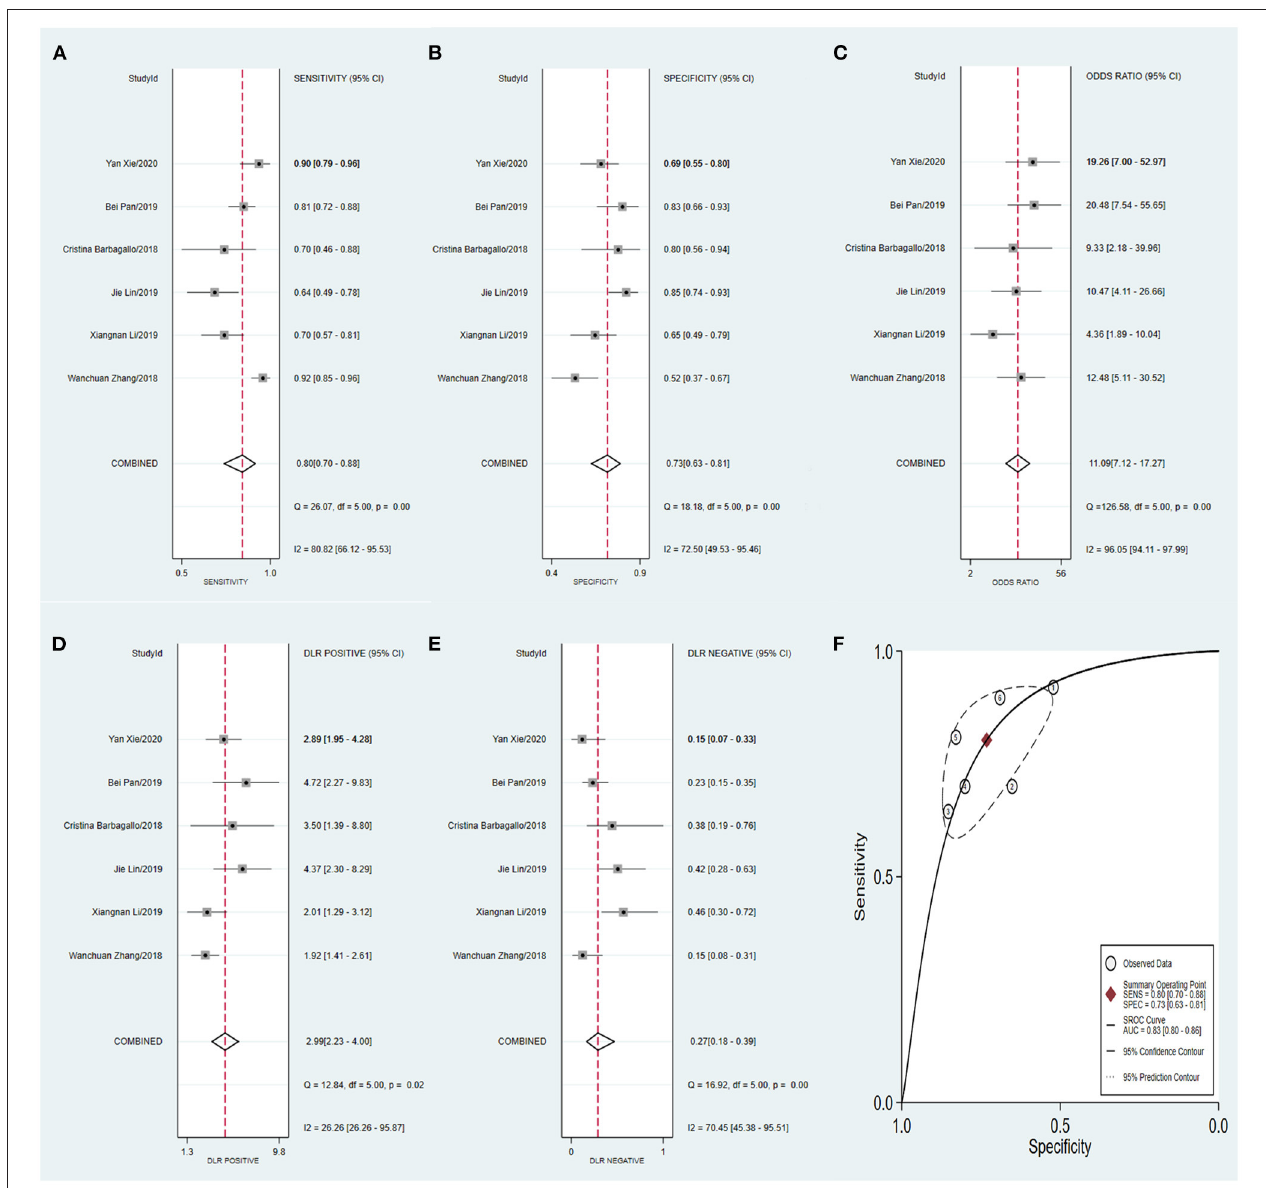
FIGURE 9 | Forest plots of pooled diagnostic power of non-tissue-derived circRNA as a biomarker for colorectal cancer, (A) Sensitivity, (B) Specificity; (C) DOR; (D) PLR; (E) NLR and (F) AUC. DOR, diagnostics odds ratio; PLR, positive likelihood ratio; NLR, negative likelihood ratio; AUC, the area under receiver operating characteristics